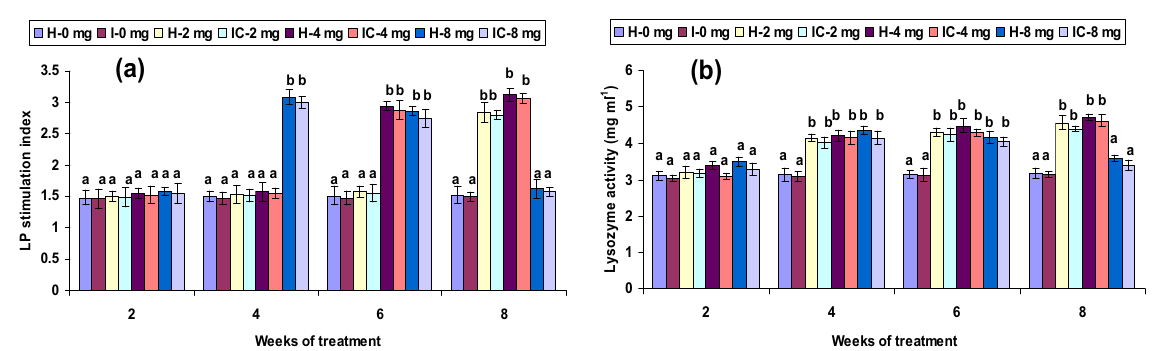
Figure 5. ( a ) Lymphocyte proliferate (LP) stimulate index and ( b ) lysozyme activity of catla (n = 6) head kidney leucocytes against A. hydrophila . H healthy, I infected. Data are expressed as mean ± SD and the statistically significant difference ( P < 0.05) between mean values as indicated in different letters in each